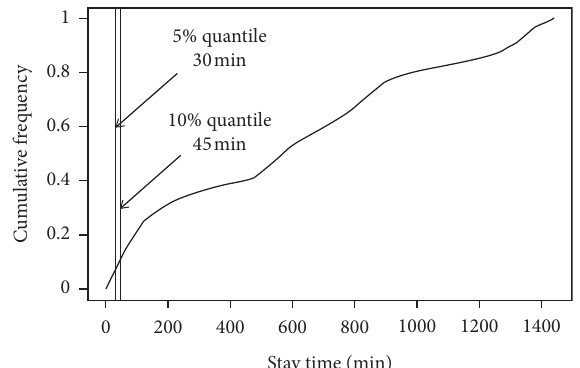
Figure 3: Cumulative frequency of activity duration.